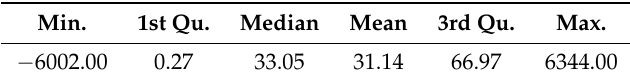
Table 1. Summary statistics for the 15 min balancing group price per MWh in the German Amprion area, 1 June 2012 to 31 May 2016.